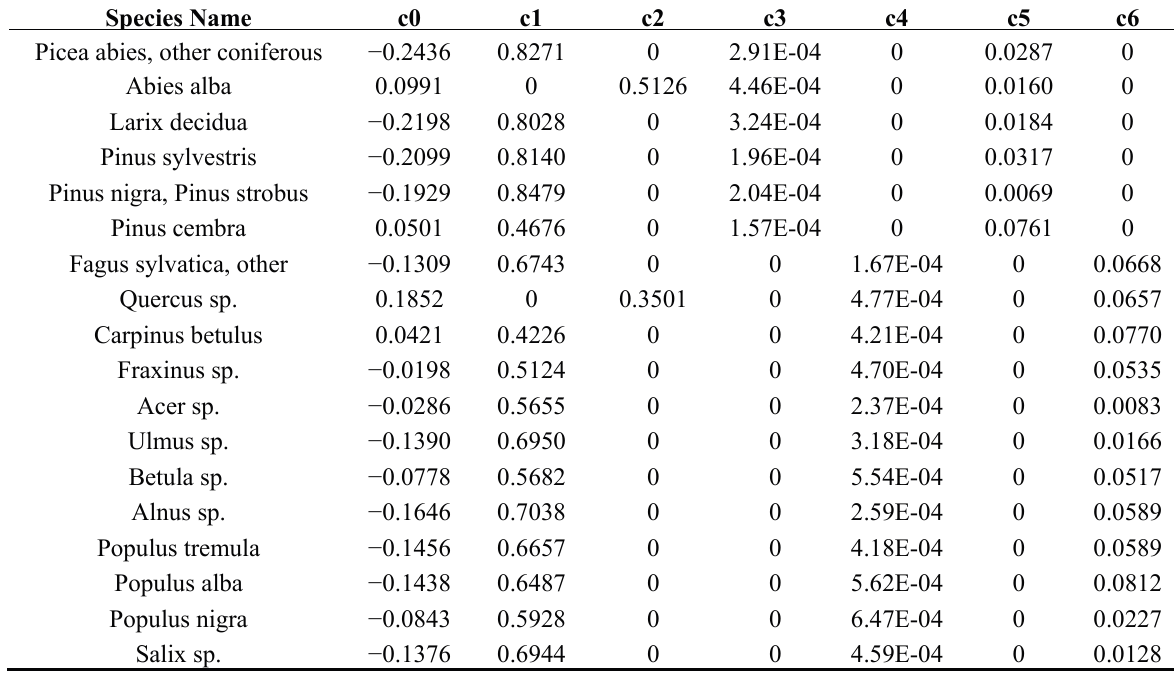
Table A2. Coefficients used in models for volume for trees with dbh ≥ 10.4 cm (Braun [57] cited in Gabler and Schadauer [17]).